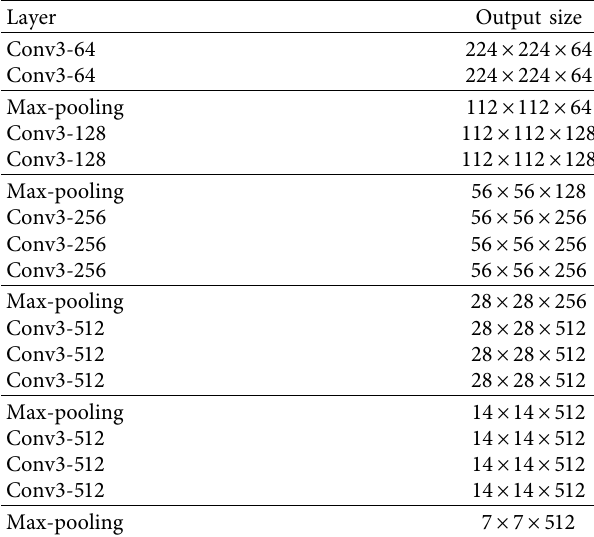
Table 1: Structure of